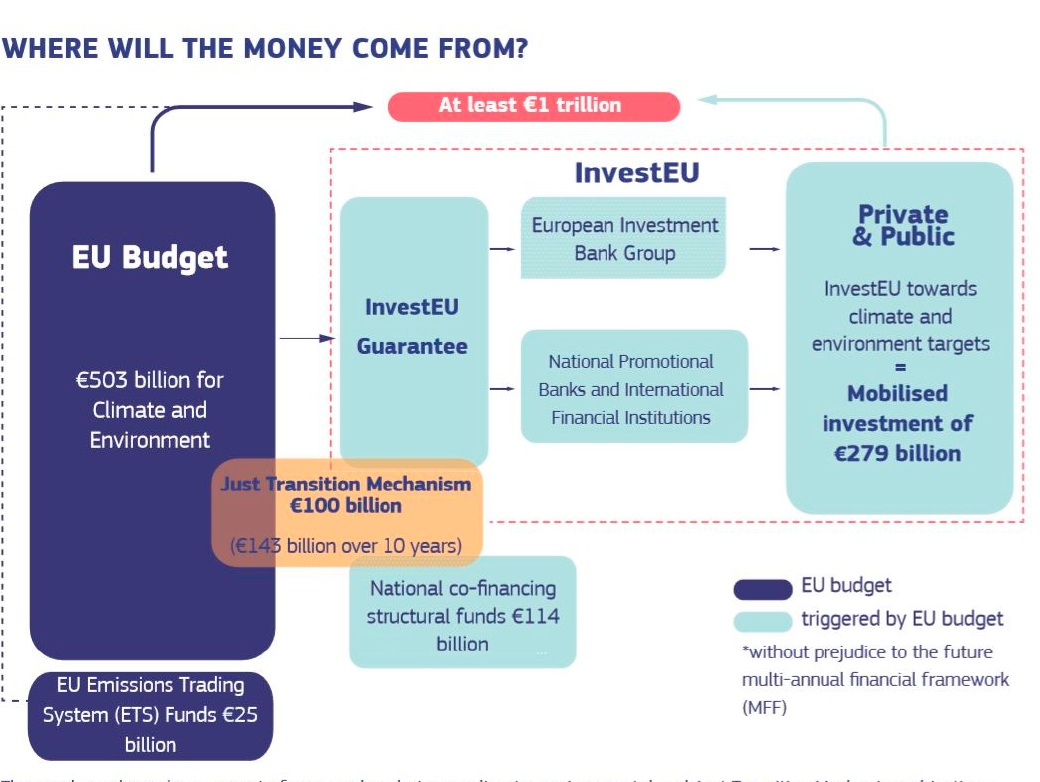
Figure 1. Funding scheme of the European Investment Plan for Green Transactions (1 trillion euros). Source: The European Green Deal Investment Plan and Just Transition Mechanism, EU Brussels, 14